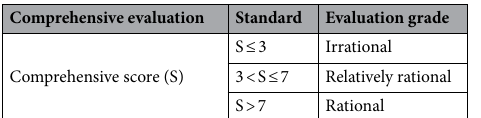
Table 4. Comprehensive evaluation criteria for optimization of sewage outfalls.